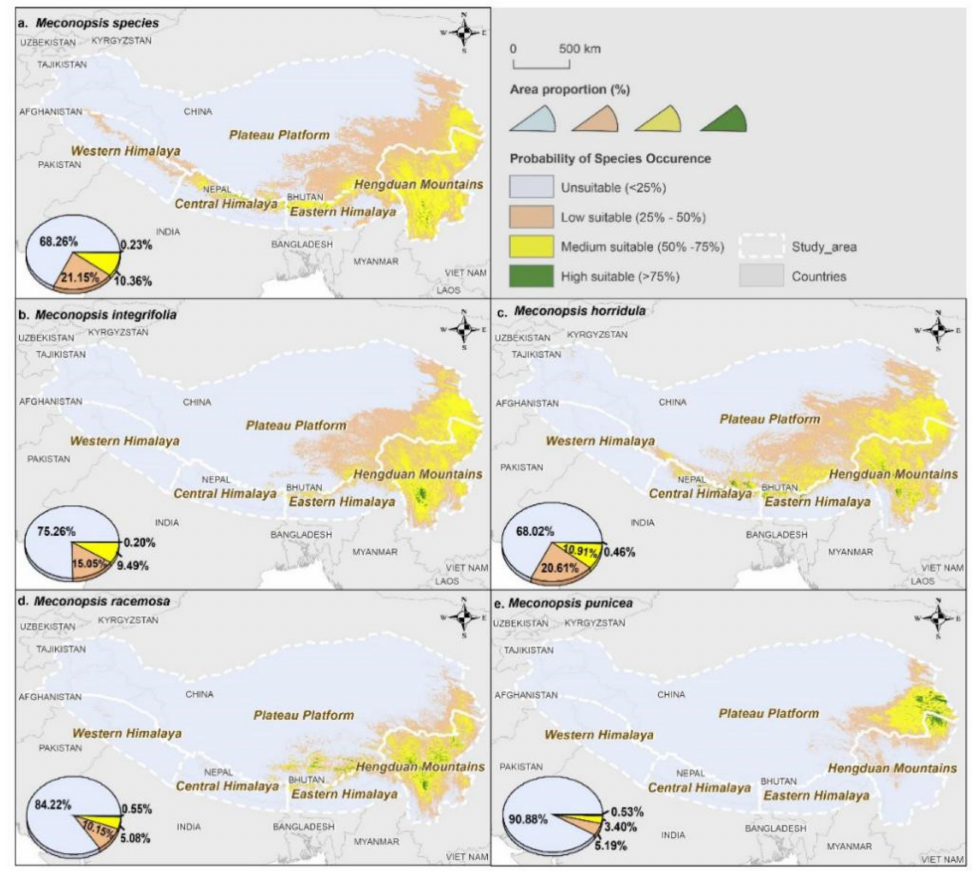
Figure 5. Potential geographic distributions of ( a ) Meconopsis species, ( b ) M. integrifolia , ( c ) M. horridula , ( d ) M. racemosa , and ( e ) M. punicea under current climate conditions in the study area.